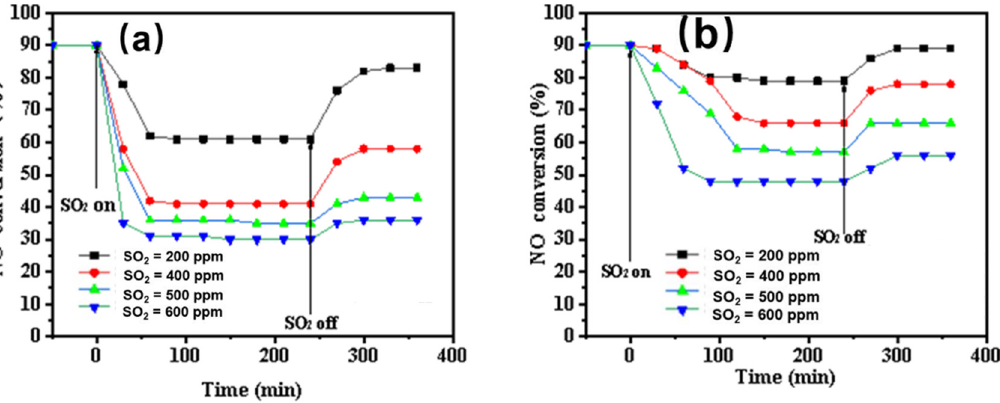
Figure 2. ( a ) Effect of different SO 2 concentrations on the denitration activity of the MF catalyst; ( b ) effect of different SO 2 concentrations on the denitration activity of the Ce 0.2 -MF catalyst.